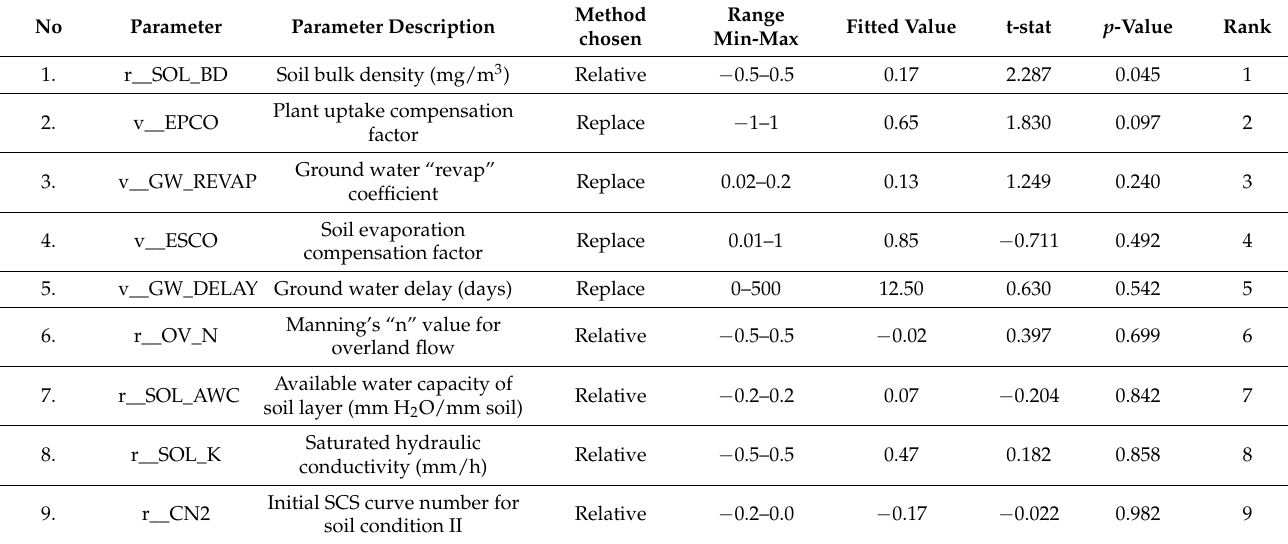
“r” denotes the relative method, and “v” denotes the replace